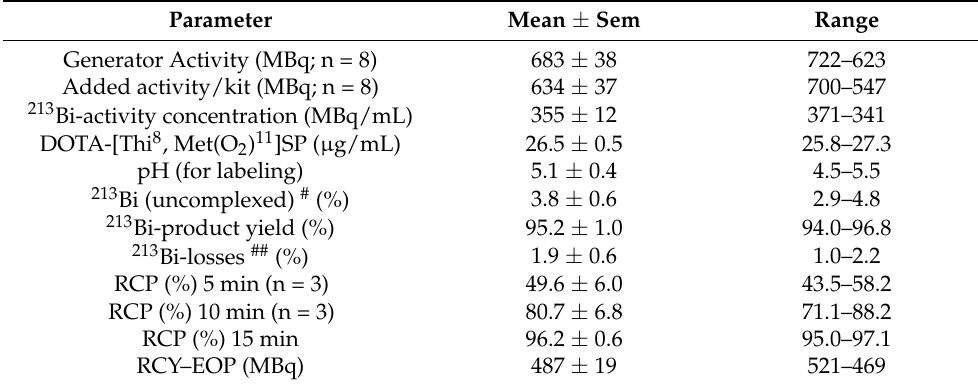
Table 5. Results for kit-based preparation of [ 213 Bi]Bi-DOTA-[Thi 8 , Met(O 2 ) 11 ]SP.